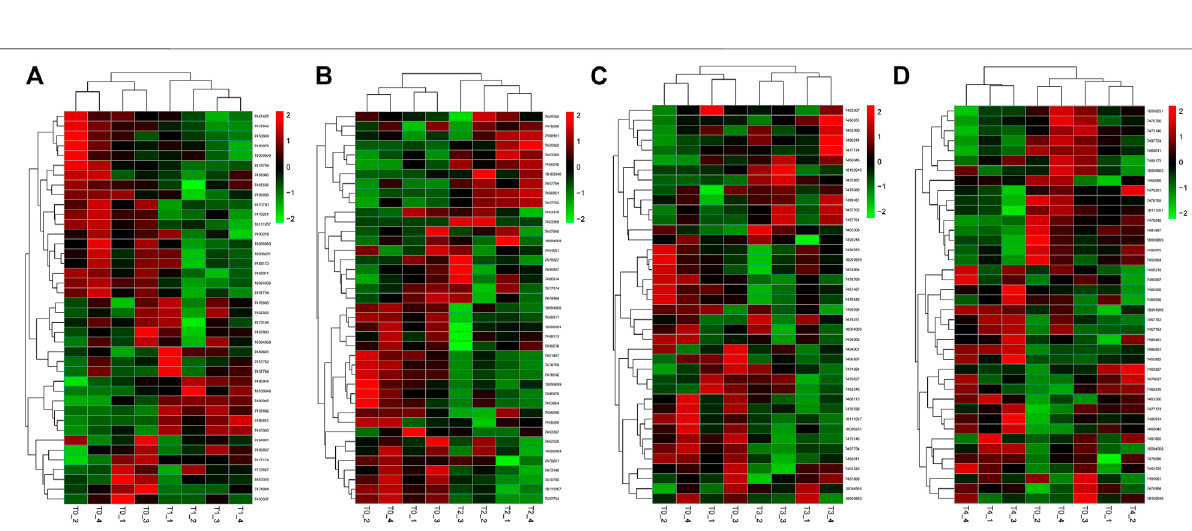
Frontiers in Genetics |